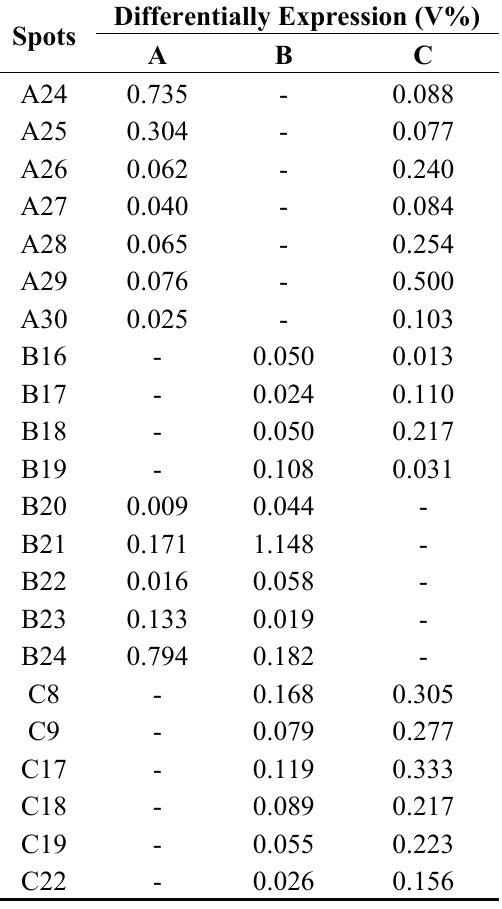
Table 2. Volume percentage (V%) of the protein spots expressed differentially in non-browned explants without somatic embryos (NBNSE, A), browned explants with somatic embryos (BSE, B), and browned explants without somatic embryos (BNSE, C) during somatic embryogenesis of Fraxinus mandshurica